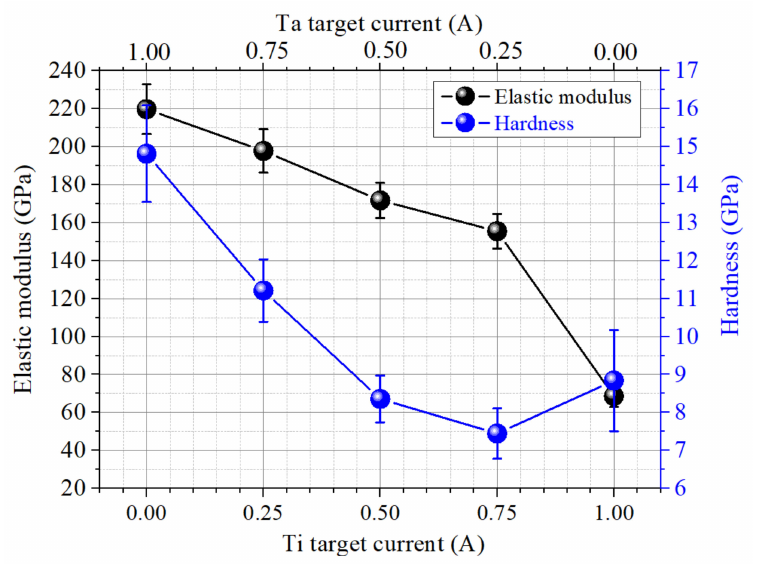
Figure 4. The variation of the indentation hardness and elastic modulus as a function of Ti and Ta target applied